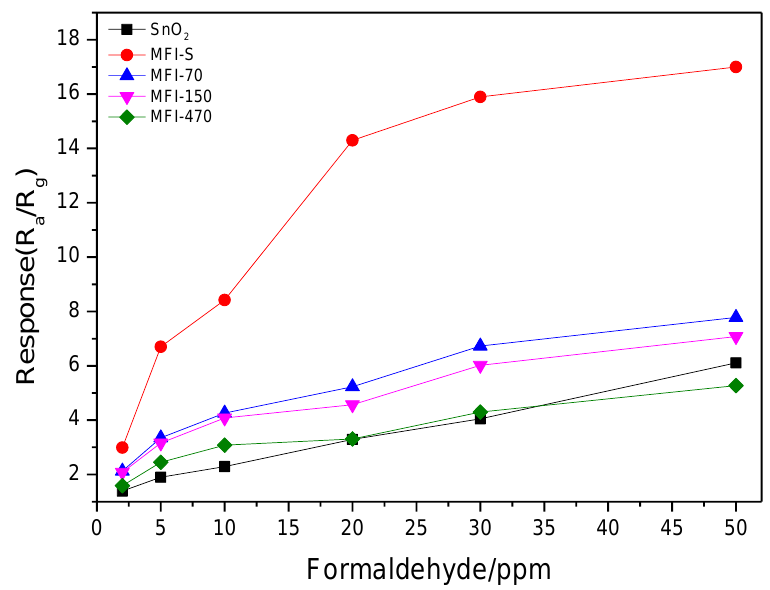
Figure 7. Sensors responses vs. concentration to formaldehyde.